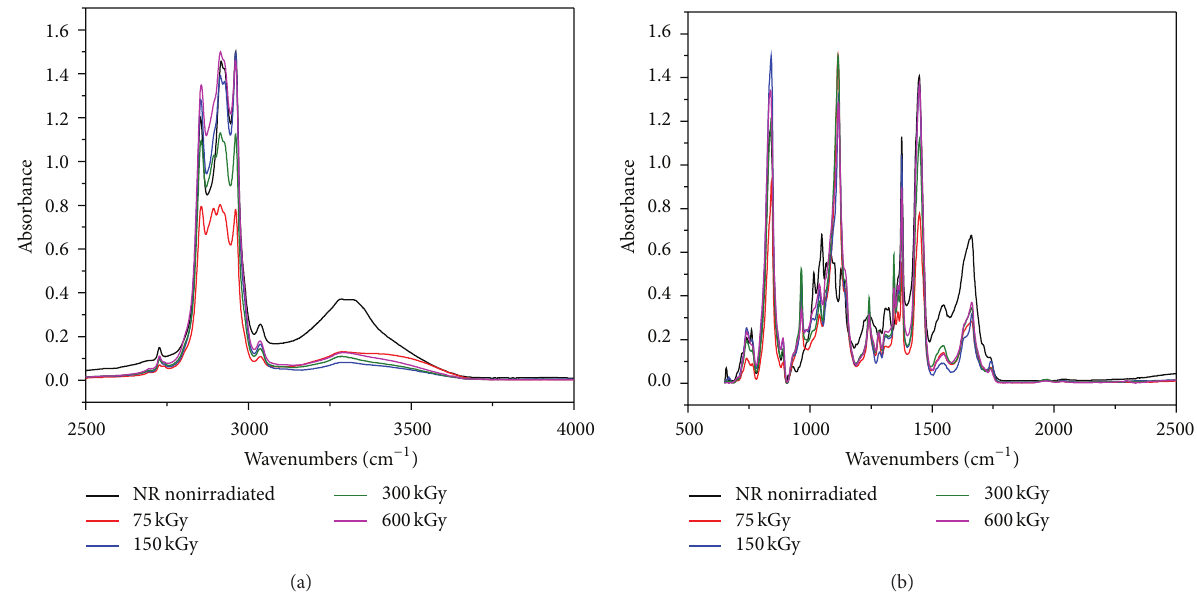
Figure 14: FTIR spectra for NR/hemp mixtures with 20 phr hemp content: (a) between 2500–4000 and (b) between